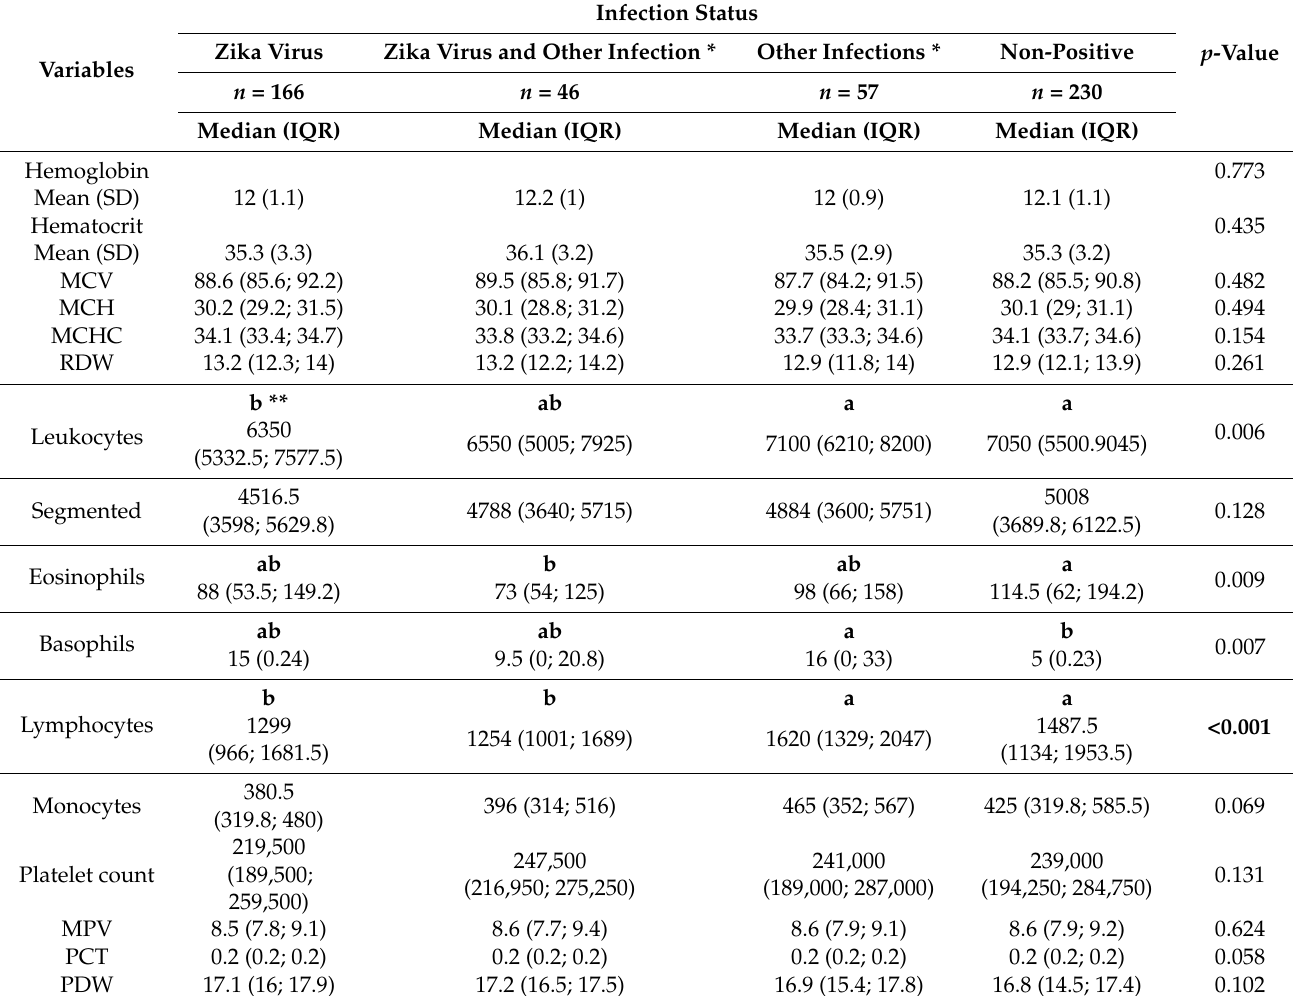
Table 2. Hematological variables according to the infection status of pregnant women with exanthematic manifestations who sought care at the Foundation of Tropical Medicine Doctor Heitor Vieira Dourado in Manaus, Brazil.